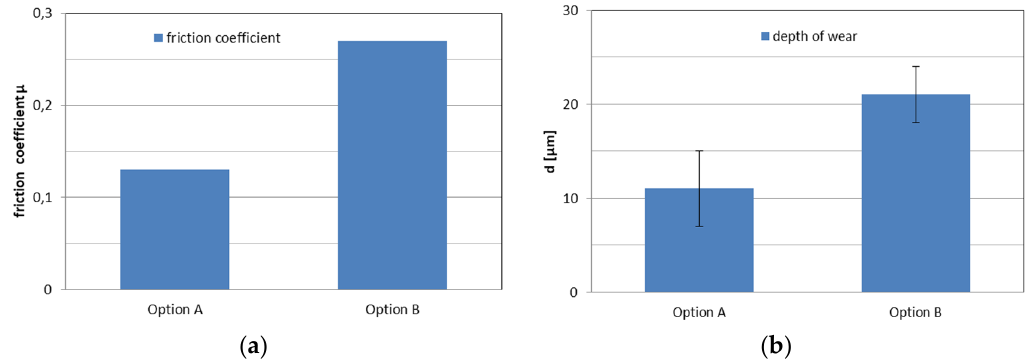
Figure 4. ( a ) Comparison of friction coefficients obtained during tribological tests; ( b ) Comparison of the maximum depth of frictional tracks.